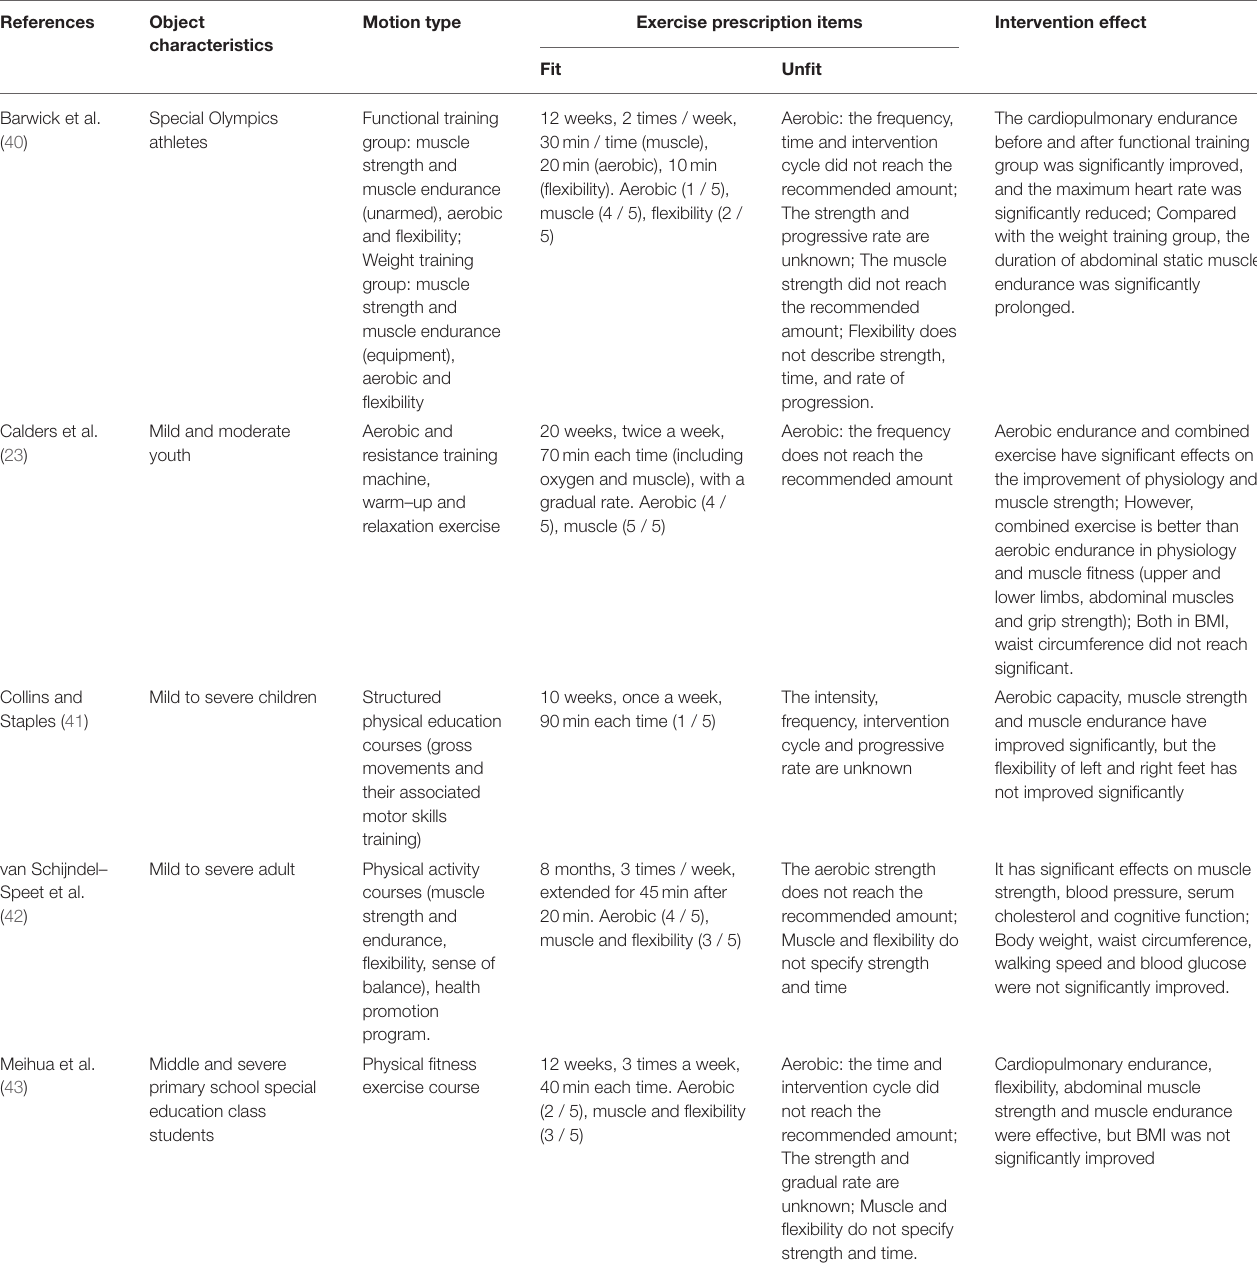
TABLE 4 | Effects of combined exercise and other exercise interventions on physical fitness of people with intellectual